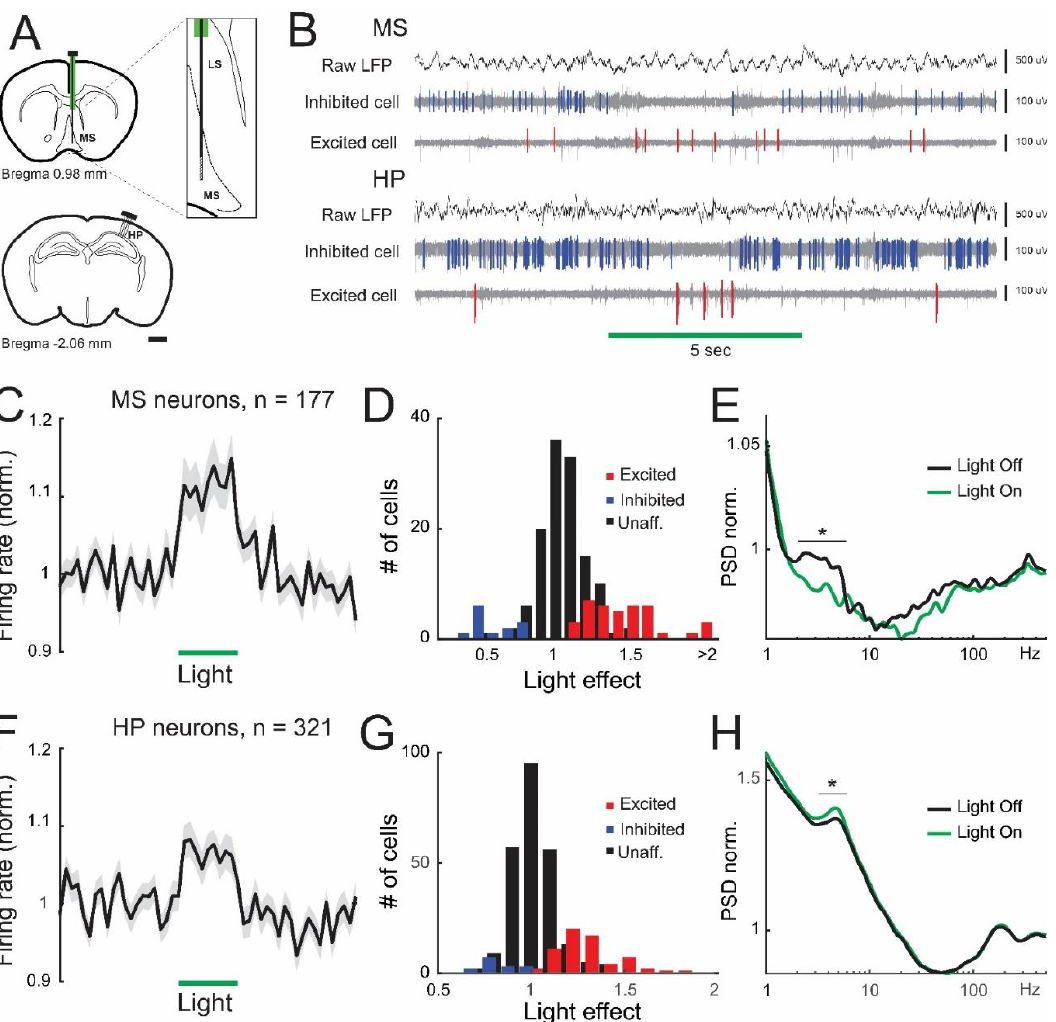
Figure 1. Neuronal activity in the medial septum and dorsal hippocampus during optical inactivation of somatostatin cells in the medial septum. ( A ) Recording locations represented in schematic coronal brain sections. A four-shank multielectrode angled 20° from the midline and an optrode (vertical line) were stereotaxically implanted in the dorsal hippocampus and medial septum, respectively. Scalebar: 1 mm. Inset, optic fiber (green) and multielectrode (black) targeted lateral septum (LS) and medial septum (MS), respectively. ( B ) Example simultaneous electrophysiological recordings (mouse NE115, recording 01) showing LFP and multiunit activity (LFP filtered 500 Hz−5 kHz) from the medial septum (MS, channels 39, 48, and 34, respectively) and dorsal hippocampus (HP, channels 20, 16, and 25, respectively). Horizontal bar depicts laser stimulation (5 s, 10 mW fiber diameter 200 um) and colors depict inhibited (blue events) and excited (red events) units. ( C ) Average normalized discharge probability for all septal neurons (mean value ± SEM, n = 177 units, 7 animals). Bin size: 500 ms. ( D ) Distribution during light stimulation for septal neurons. Blue and red bars denote statistical difference from shuffled data. ( E ) Averaged power spectral density (PSD) for all recorded neurons before (black line) and during light stimulation (green line). Asterisk in band 2 – 6 Hz: paired t -test, p = 0.016. ( F ) Average normalized discharge probability for all hippocampal neurons (mean value ± SEM, n = 321 units, 7 animals). Bin size: 500 ms. ( G ) Distribution during septal stimulation for hippocampal neurons. Blue and red bars denote statistical difference from shuffled data. ( H ) Averaged power spectral density (PSD) for all recorded neurons before (black line) and during light stimulation (green line). Asterisk in band 4 – 7 Hz: paired t -test, p = 0.0003.